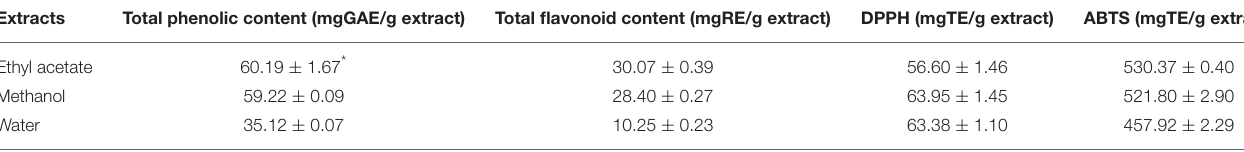
TABLE 3 | Total phenolic and flavonoid contents, and free radical scavenging (DPPH and ABTS) activities of the extracts. Extracts